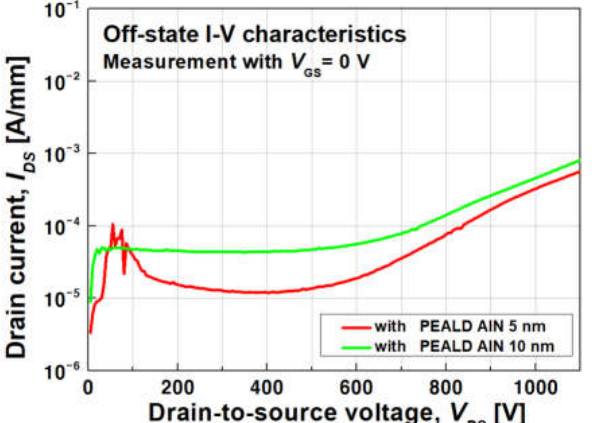
Figure 12. Off-state breakdown characteristics of the fabricated thin-AlGaN/GaN E-mode MIS- HFET with PEALD AlN films.